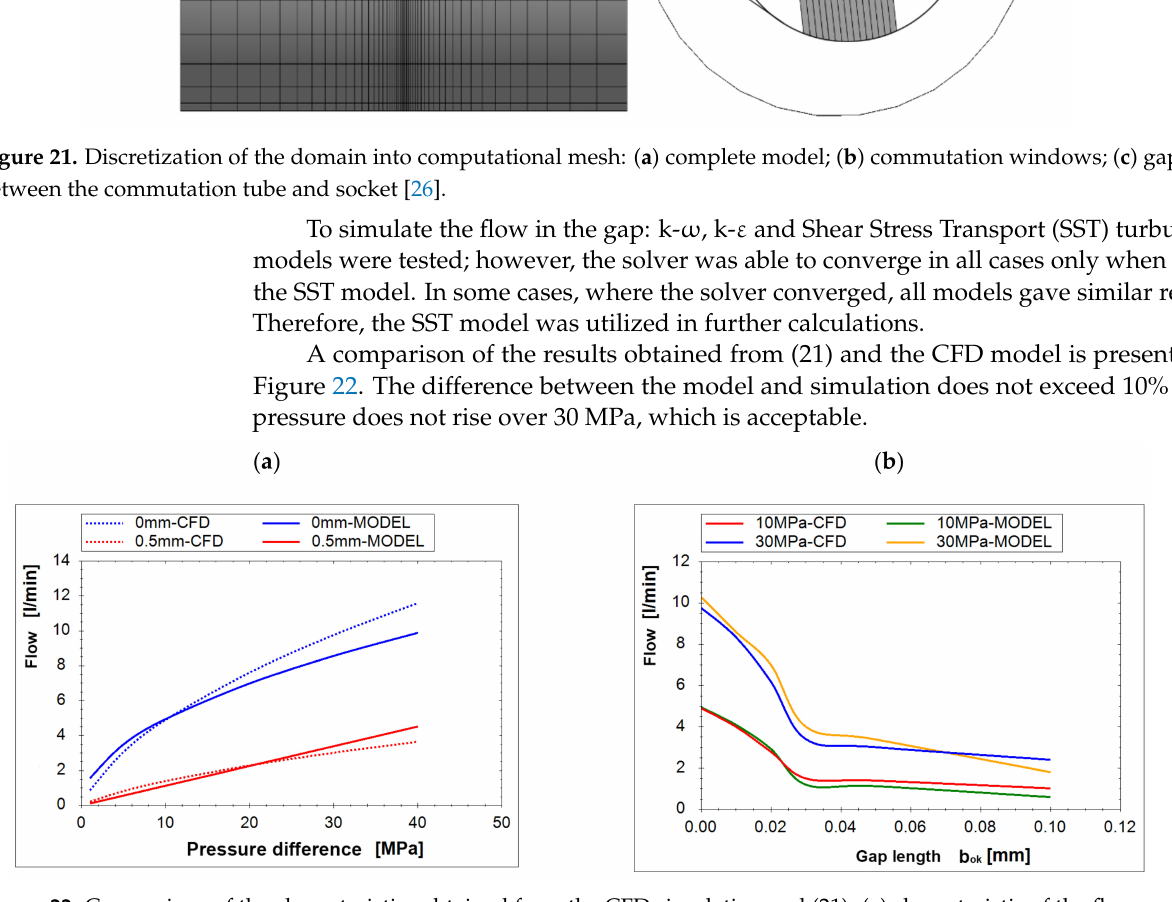
Figure 22. Comparison of the characteristics obtained from the CFD simulation and (21): ( a ) characteristic of the flow as a function of the pressure difference ∆ p for different gap lengths b ok ; ( b ) characteristic of the flow as a function of the gap length b ok for different pressure differences ∆